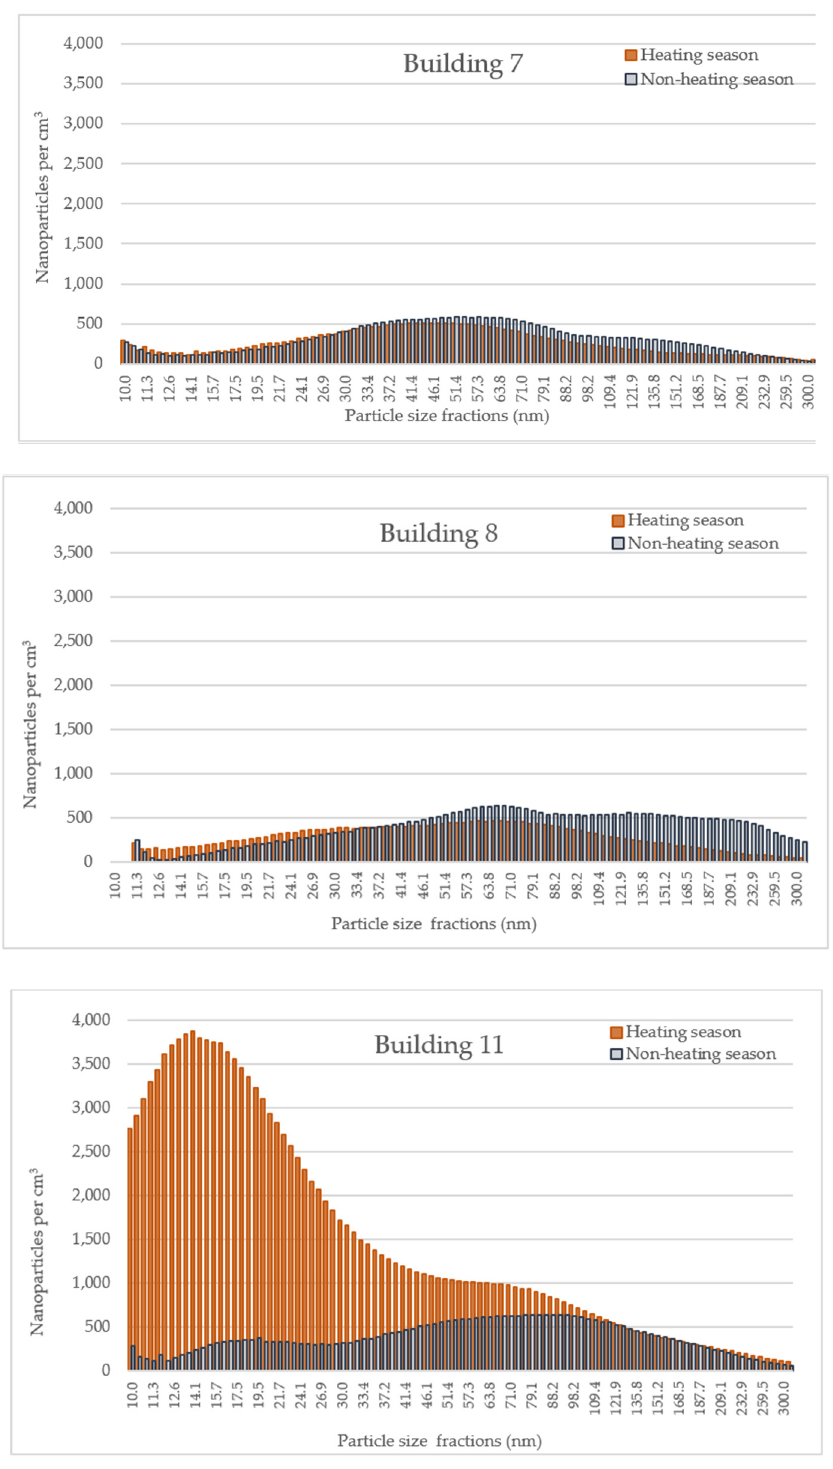
Figure 5. Concentrations of nanoparticles in different size fractions (10–300 nm) during the heating and the non-heating seasons in three buildings located at different distances from a busy street. Top : Building 7 (older office building, 970 m from a busy street). Middle : Building 8 (older office building, 570 m from a busy street). Bottom : Building 11 (older office building, 130 m from a busy street and 170 m from a bus terminal).